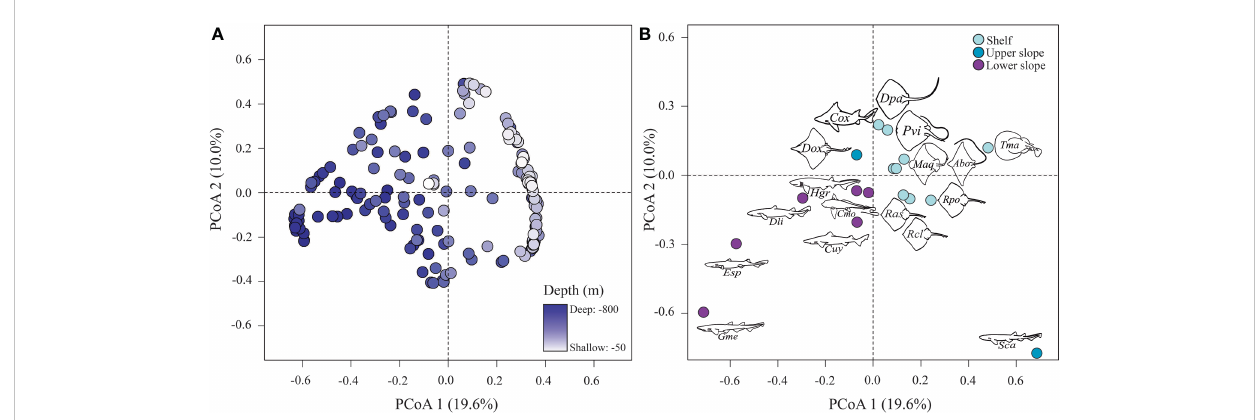
FIGURE 3 (A) Principal coordinate analysis, where the locations of points re fl ect compositional differences among hauls based on species-speci fi c density data. The color of the points represents the mean depth of the haul. (B) The same ordination showing scores for each species driving differences in the composition of the community. Each point represent an species and is acompanyed by its ilustration and initials (the fi rst letter for genus and the two other for species). Point colors represents the preferred depth range of the particular species accoding to COG analysis (Table